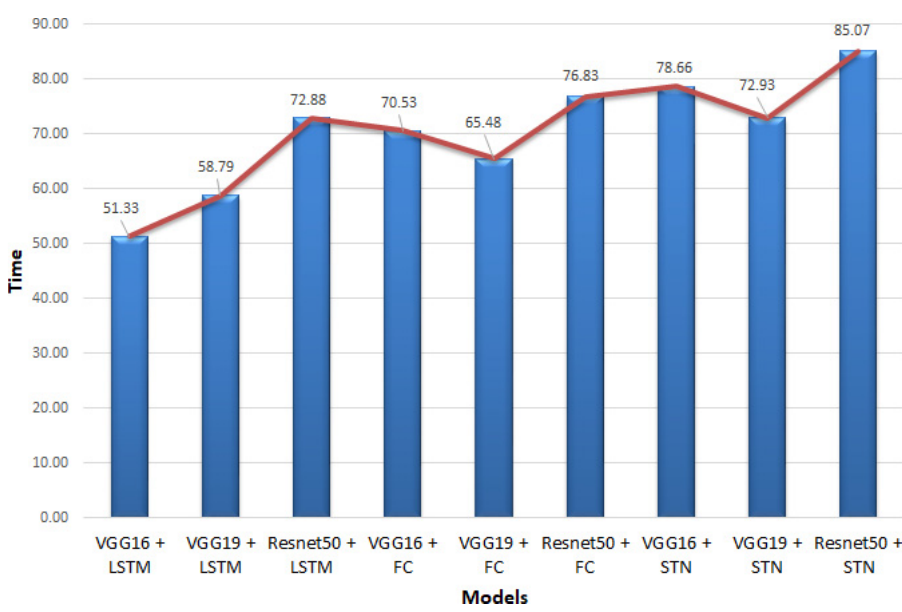
Fig. 20. Execution time of the